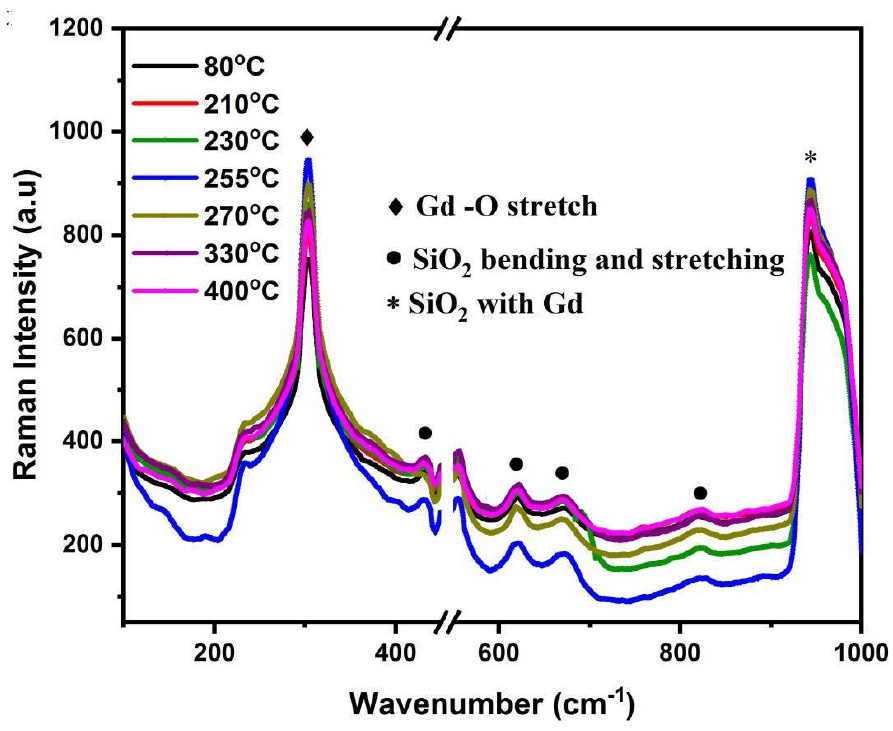
Figure 5. Room temperature Raman spectra of samples grown at 80 °C, 210 °C, 240 °C, 255 °C, 270 °C, 330 °C and 400 °C. A break is done from 450 cm − 1 to 550 cm − 1 to avoid the Si strong peak.